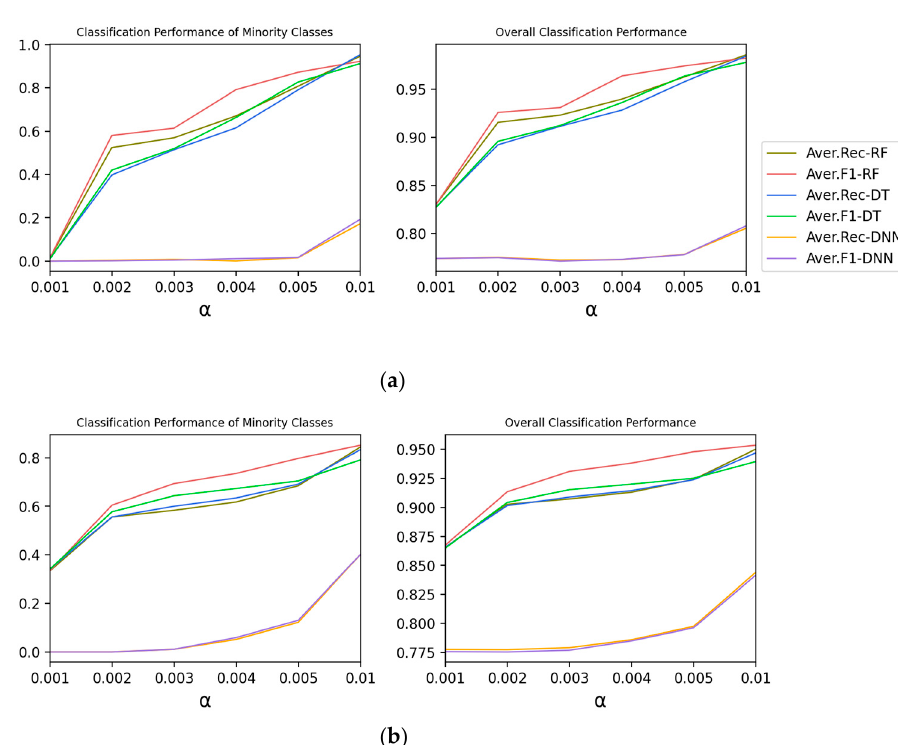
Figure 2. The effect of α on the classification performance of Type 1. ( a ) Moore Dataset; ( b ) CICIDS 2017 Dataset